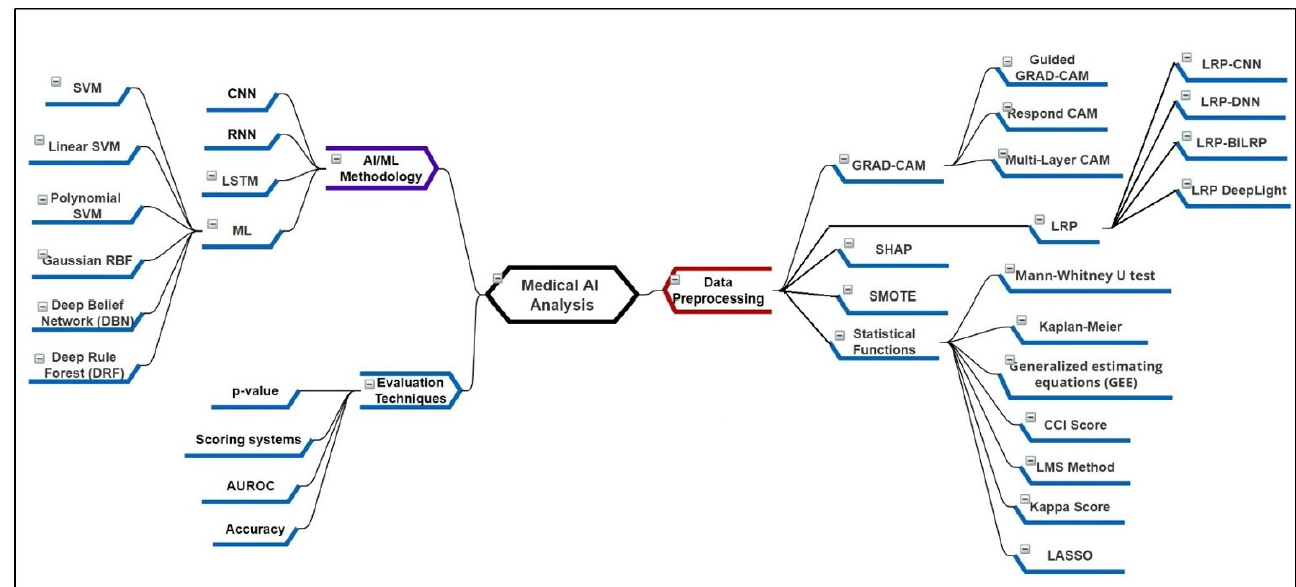
Figure 1. MindMap diagram for the medical AI analysis.